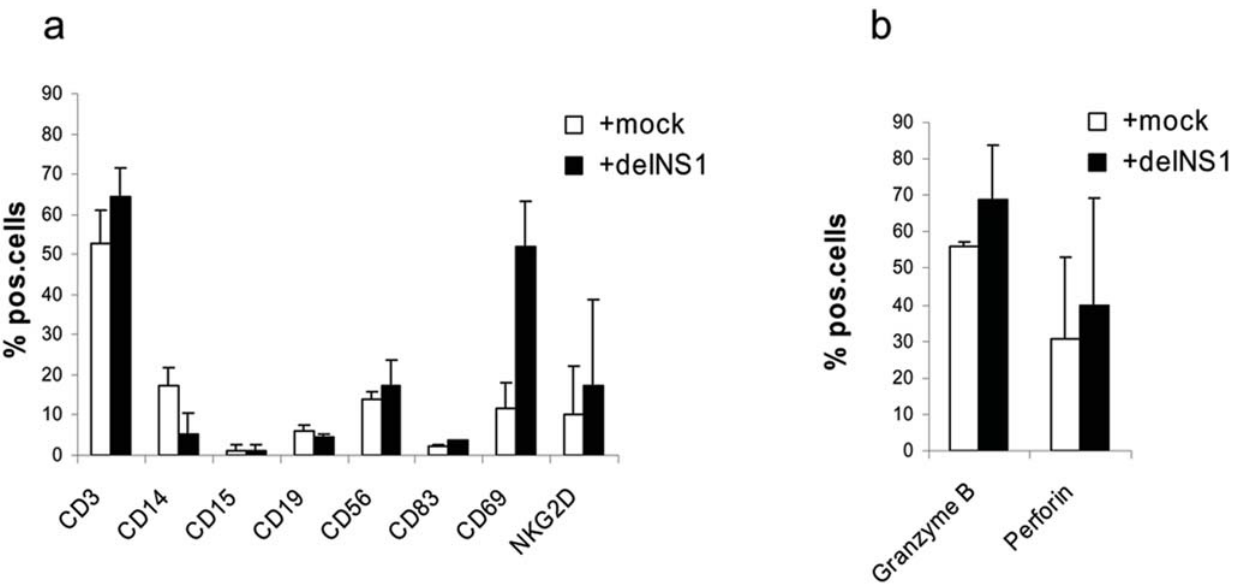
Figure 6. Expression of extracellular and intracellular markers in PBMCs after infection with delNS1 virus. (a) Surface marker expression of mock-treated or infected PBMCs with delNS1 virus was evaluated. PBMCs were infected with delNS1 virus (m.o.i.=0.02) or not infected and cultured for 24 hours. Then the indicated markers were assessed by flow cytometry using specific fluorescent antibodies. Mean results and standard deviation for the percentage of positive cells are shown from three independent experiments, each performed with cells derived from a different donor. (b) Intracellular marker expression of comparably treated PBMCs was measured after antibody staining of permeabilized cells. Mean results ( 6 SD) for the percentage of positive cells are shown from three independent experiments, each performed with cells derived from a different